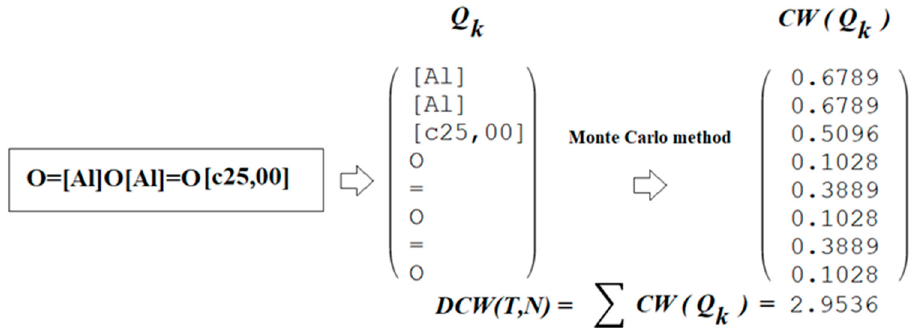
Figure 3. The generalized scheme of calculation of the optimal descriptor based on the correlation weights ( CW ) of codes of quasi-SMILES (i.e., Q k ); the correlation weights CW ( Q k ) are obtained by the Monte Carlo